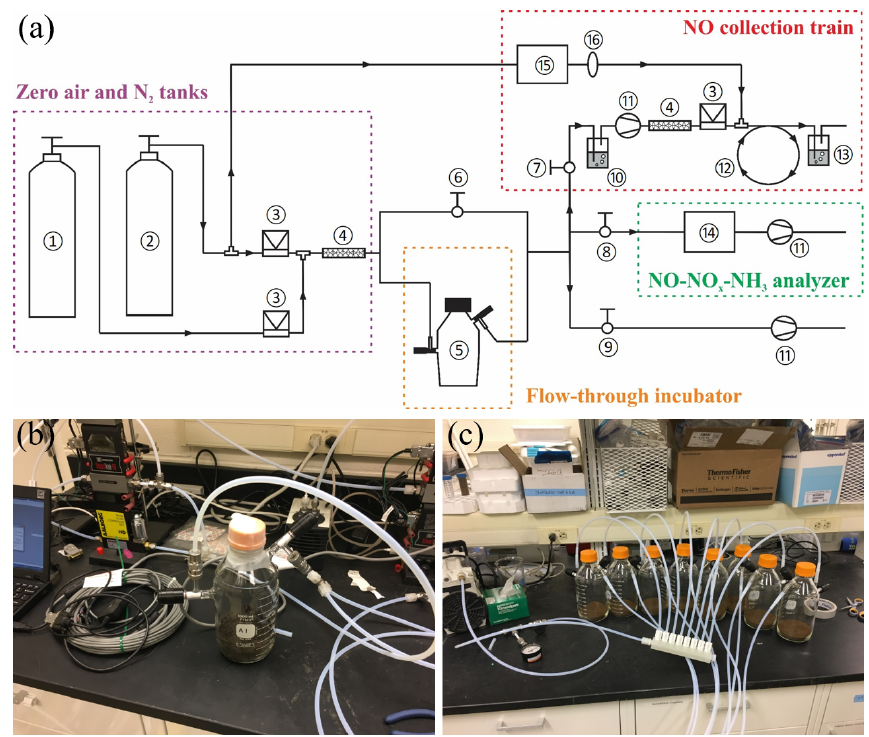
Figure 1. (a) Schematic of the DFC system (not to scale) consisting of the following: (1) zero air tank, (2) N 2 tank, (3) mass flow controller, (4) Nafion moisture exchanger, (5) flow-through incubator, (6–9) needle valves for controlling vacuum and flushing of the DFC system, (10) HONO scrubber, (11) diaphragm pump, (12) Teflon reaction tube, (13) gas washing bottle containing TEA solution, (14) NO–NO x –NH 3 analyzer, (15) O 3 generator, and (16) in-line PTFE particulate filter assembly. (b) Photo of the flow-through incubator. (c) Photo of the Teflon purging manifold for connection of the incubators in